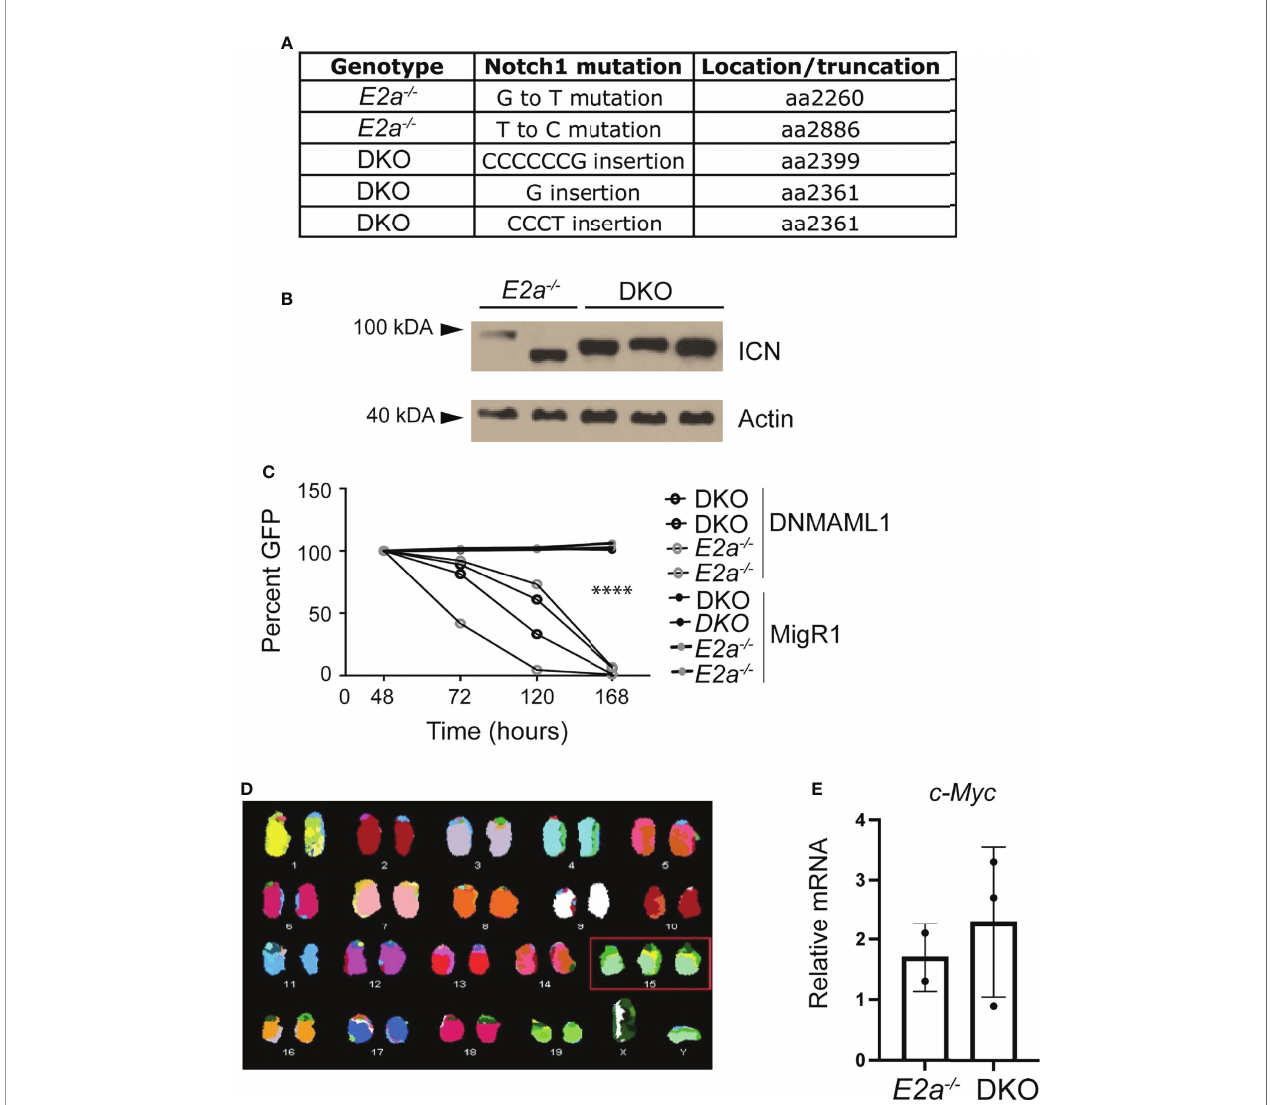
FIGURE 6 | DKO leukemias require Notch1 signaling and have ampli fi cation of chromosome 15. (A) Identi fi cation of mutations in the Notch1 gene in two E2a -/- and 3 DKO leukemias. (B) Western Blot Analysis for cleaved ICN1 in the indicated leukemia lines. Actin is shown as a loading control. (C) Relative GFP expression in leukemias of the indicated genotype after transduction with MigR1 or MigR1-DNMAML. The frequency of GFP + cells was assessed by fl ow cytometry at the indicated times after transduction. ****p < 0.0001 Students t-test on MigR1 versus DNMAML infected cells (D) Spectral karyotyping analysis of metaphase cells isolated from a DKO leukemia. (E) qRT-PCR analysis for c-Myc in 2 E2a -/- and 3 DKO